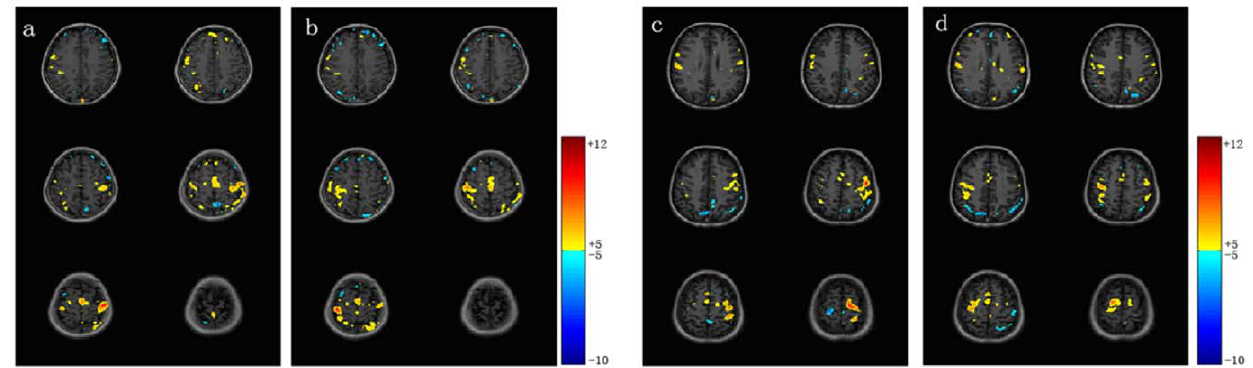
Figure 3. The activation and deactivation maps from two subjects’ bilateral hand data. The voxels with Z -scores greater than 5.0 are considered to be activated, while the voxels with Z -scores less than 2 5.0 are considered to be deactivated. These voxels are mapped in different colors according to their Z -score values. (a) and (b) are for the left and right hand data, respectively, from subject one, while (c) and (d) are for the left and right hand data, respectively, from subject